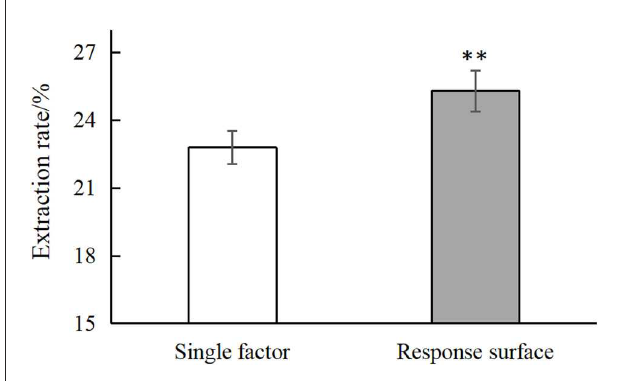
FIGURE3 Comparison of single factor and response surface. “**” means very significant difference ( P < 0.01).